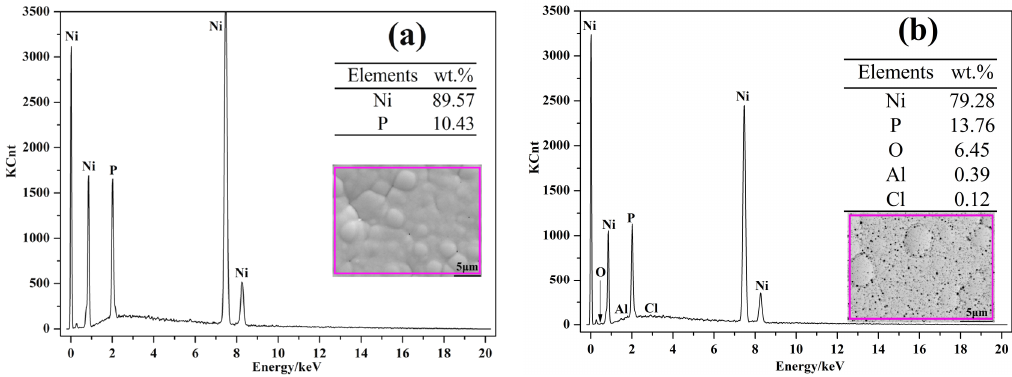
Figure 4. Cont . Figure 4. Cont .